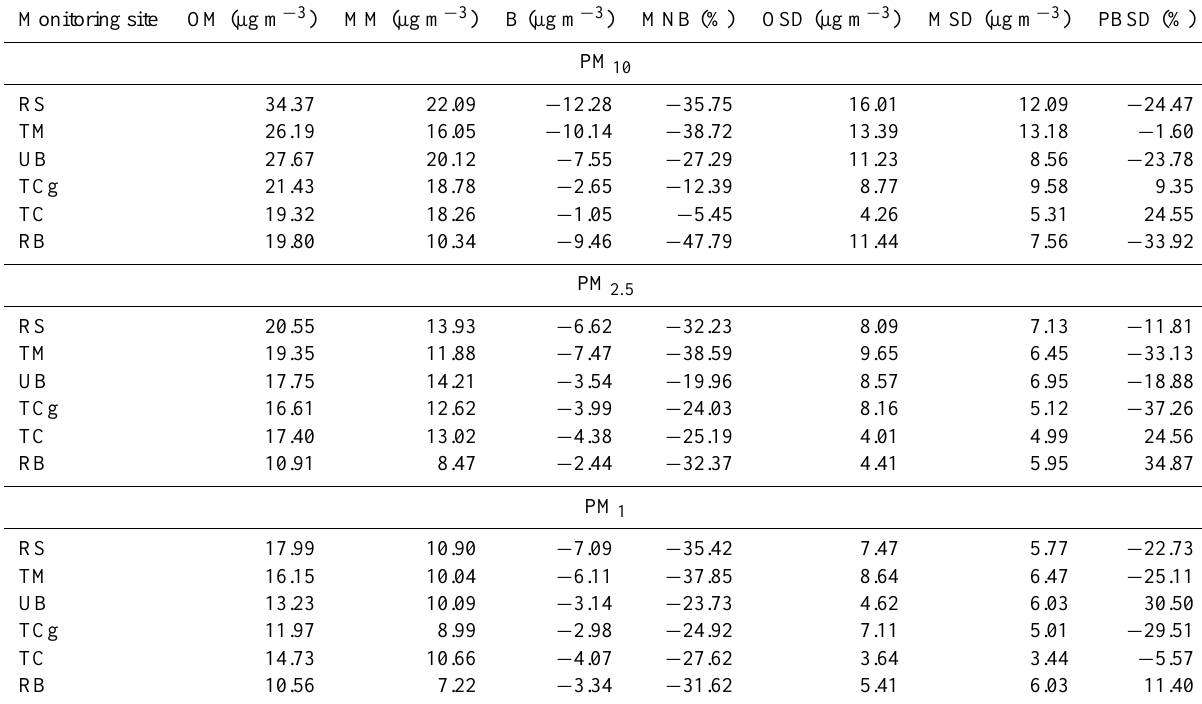
Table 8. Results of the evaluation of the modelling system applied during the SAPUSS field campaign versus observations: observed mean (OM); model mean (MM); bias (B); mean normalized bias (MNB); observed standard deviation (OSD); model standard deviation (MSD); percentage bias of the standard deviation